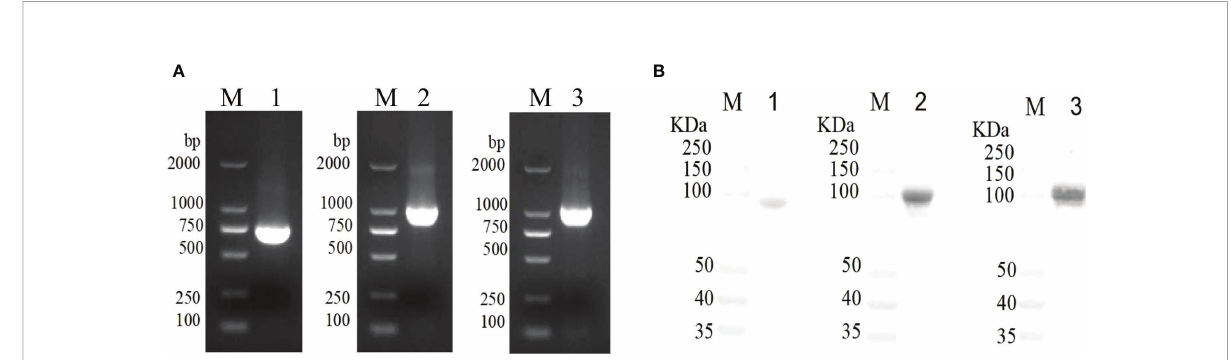
FIGURE 1 Gene cloning and immunogenicity of rVacJ, rPlpE,rOmpH lipoprotein in a duck model. Panel (A) PCR ampli fi cation of VacJ, PlpE, OmpH genes from P. multocida A:1 strain PMWSG-4. Lane M: DNA standard ladder, Lane 1,2 and 3: Ampli fi ed VacJ(746bp), PlpE(1021bp), and OmpH(1083bp) gene product. Panel (B) Western blot of protein rVacJ, rPlpE and rOmpH. Protein standard marker (lane M), Immunoblot of rVacJ(84.4kDa), rPlpE(94.8kDa), rOmpH(96.7kDa) (lane 1, 2 and